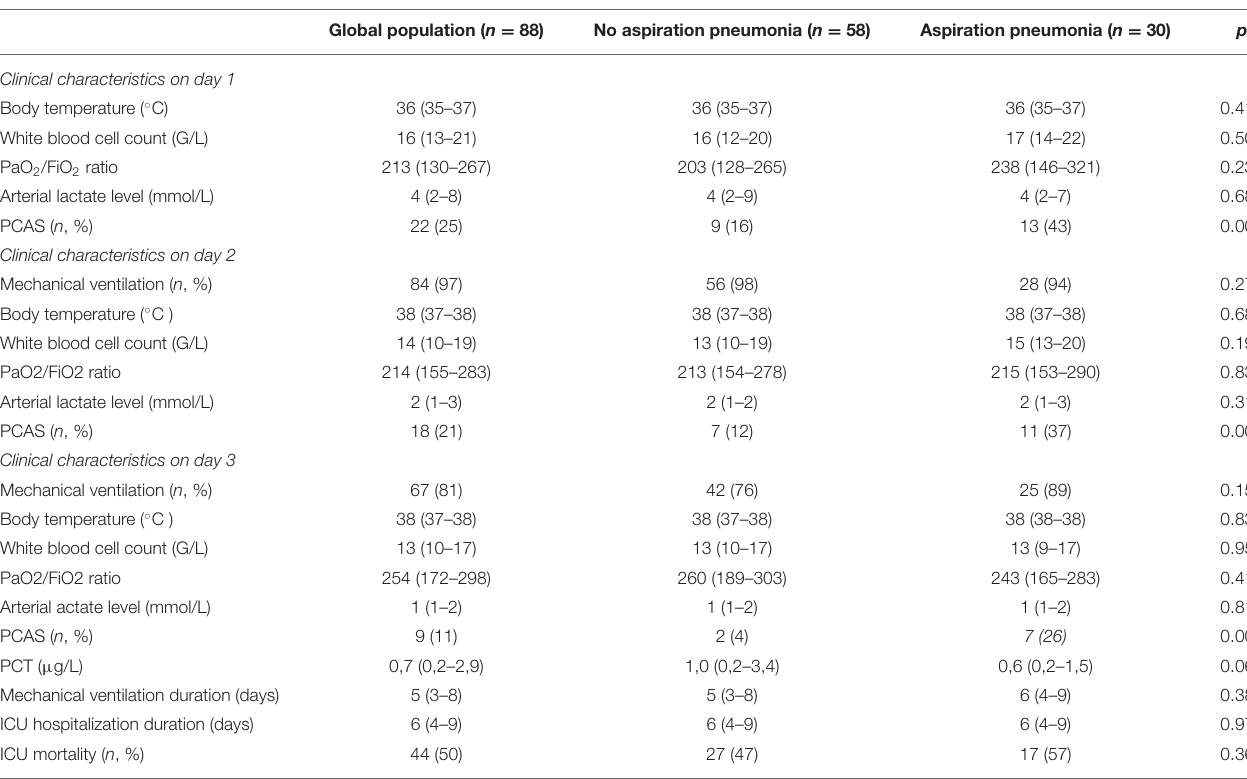
TABLE 2 | Evolution of patients’ clinical characteristics from day 1 to